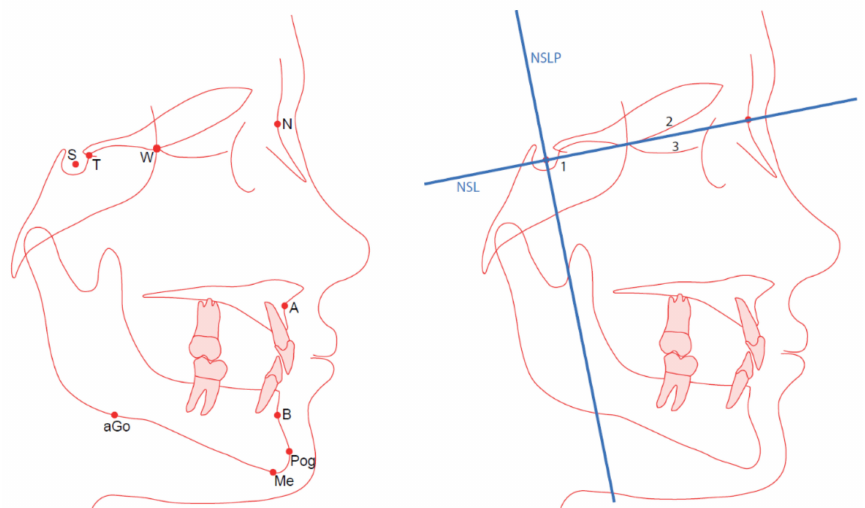
Figure 1. ( Left panel ) The used landmarks are S, sella; T, tuberculum sella (Walker’s point); W, wing point (sphenoethmoidal); N, nasion; A, A-point; B, B-point; Pog, pogonion; Me, menton; aGo, anterior gonion. ( Right panel ) The reference lines (NSL and NSLP) and superimposition using the Björk’s BD, BT, and BS methods, performed on the 1, anterior sella; 2, cribriform plate; and 3, ethmoidal